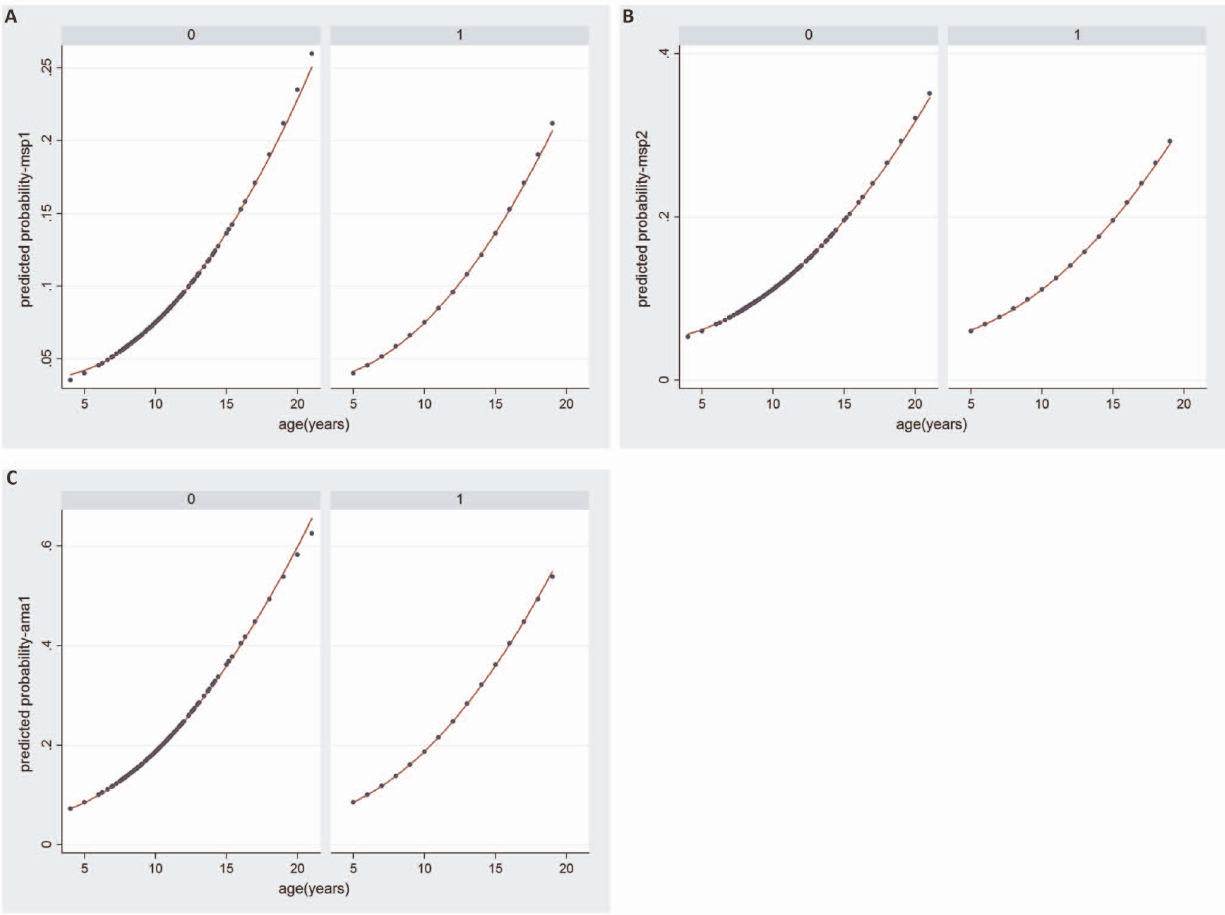
Figure 2. Age specific seroprevalence according to parasite prevalence (low versus high). A. MSP1 19 . B. MSP2. C. AMA1. 0=Sites with plasmodium prevalence # 20% (low). 1=Sites with plasmodium prevalence . 20% (high).